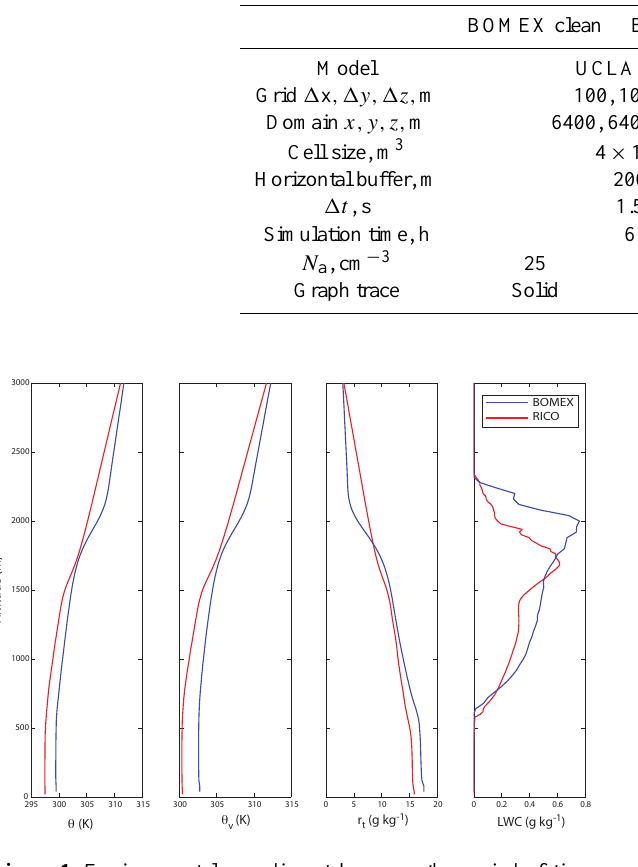
Figure 1. Environmental soundings taken over the period of time from which clouds are selected. With the exception of LWC, the profiles are clear-air domain